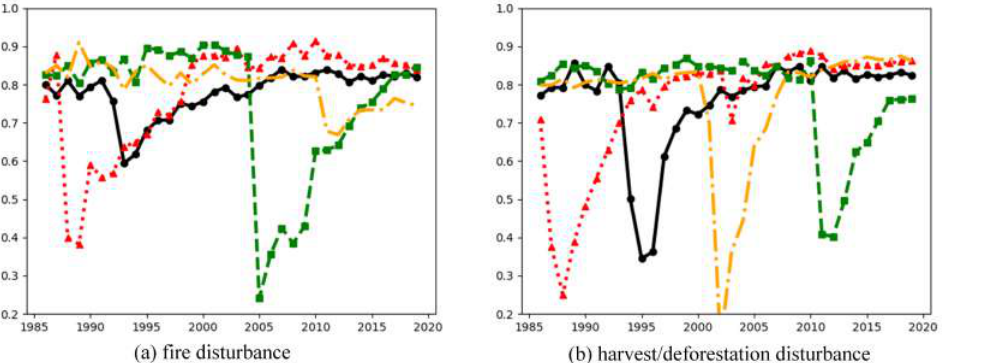
Figure 2. The typical time-series curves for different types of forest disturbances. ( a ) represents fire disturbance while ( b ) represents harvest/deforestation.